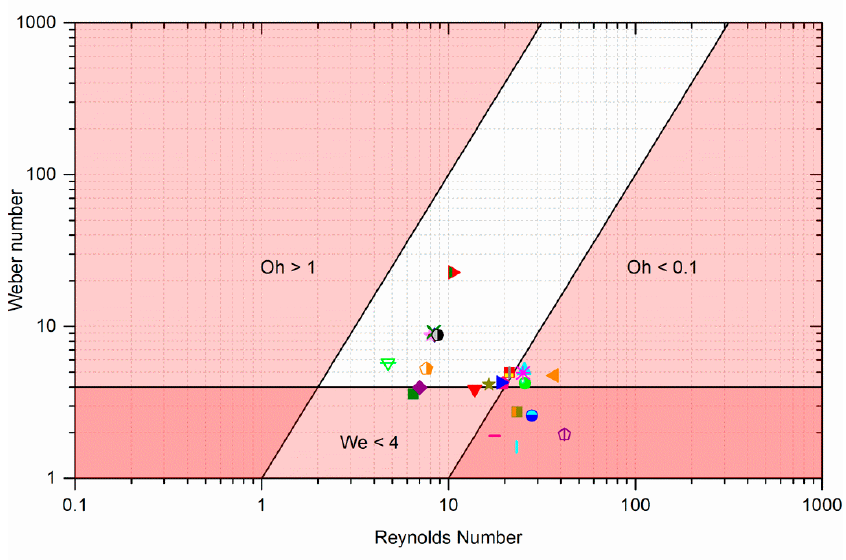
Figure 1. Plot which shows the operating window for a stable printing (white area) base on the values of the Reynolds and Weber numbers. The values of some of the investigated graphene inks are displayed in the